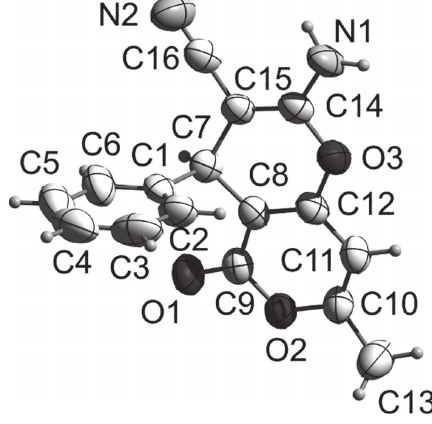
Table 1: Data collection and handling.